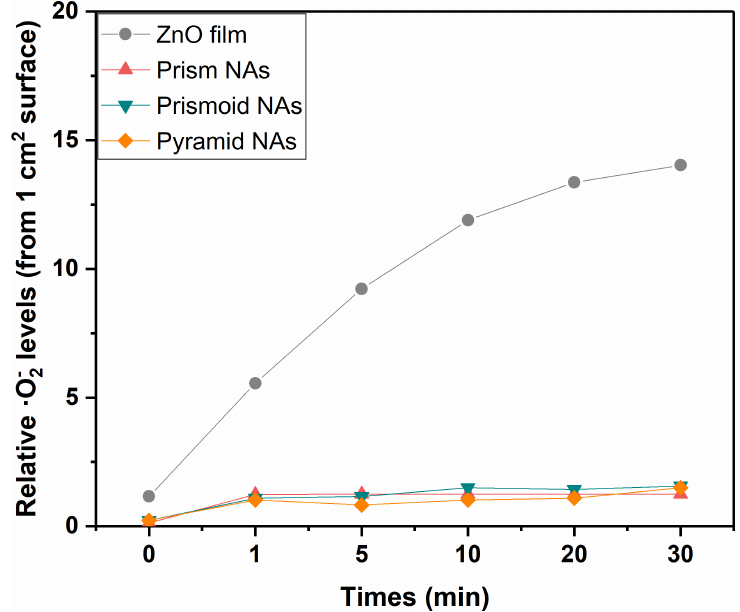
of ZnO film and three ZnO NAs as the function of time. Figure S4: Production of · O − 2 G: Difference in H 2 O 2 productivity of ZnO films and ZnO NAs in dark